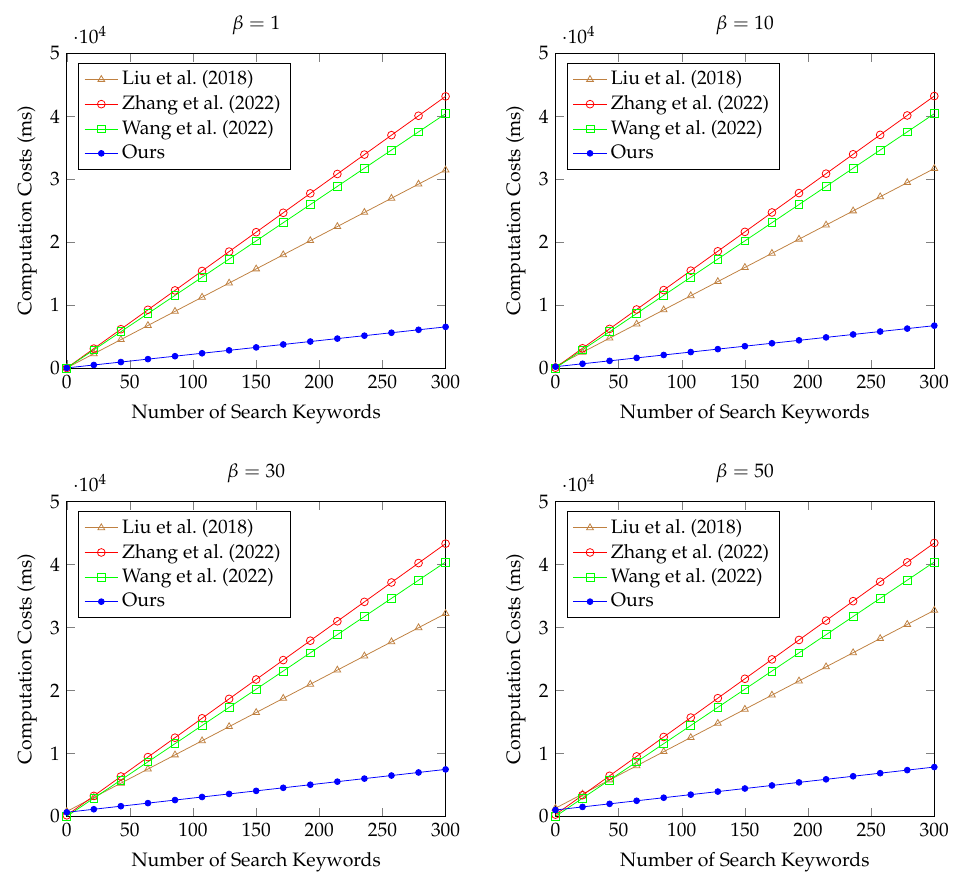
Figure 7. Computation costs comparison as the number of search keywords increases [25,28,31].